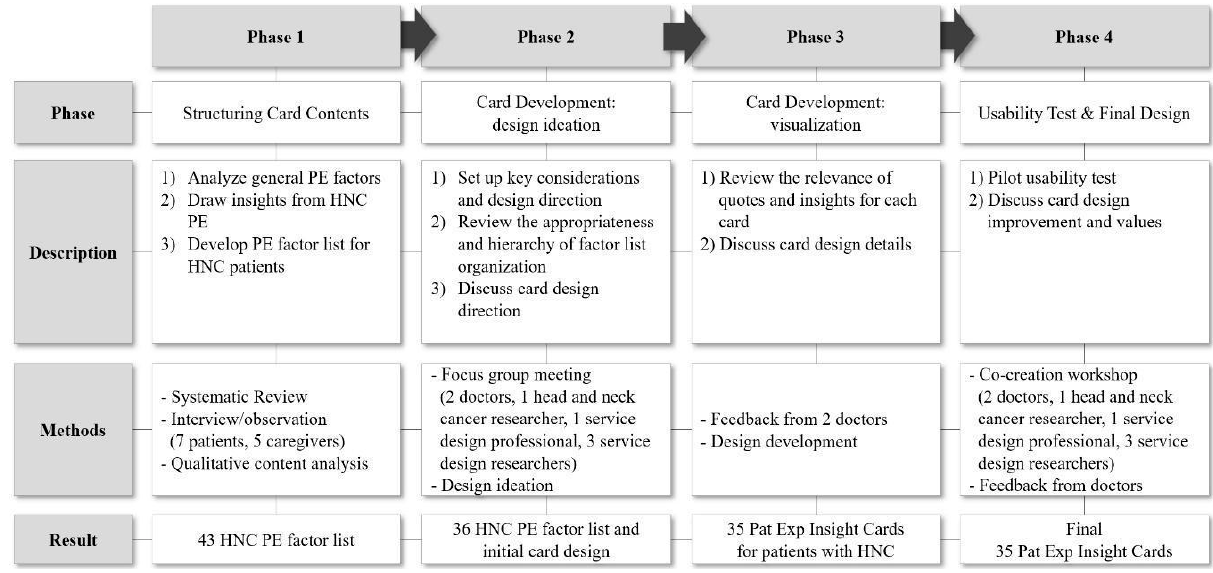
Figure 1. Flow diagram of study.